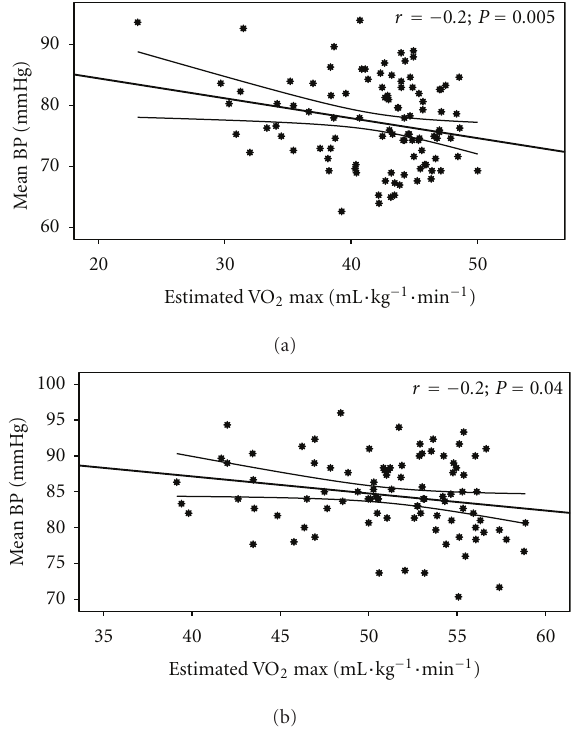
Figure 5: Postocclusion blood flow in the poor, average, and high estimated VO 2 max groups. $ = P < 0 . 05 versus high groups.